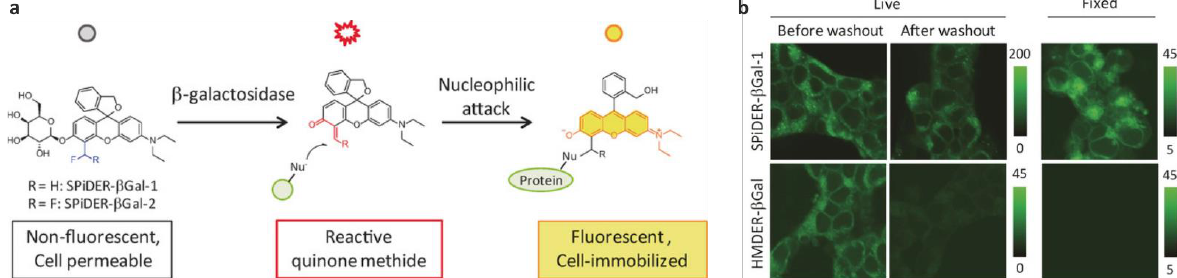
Figure 10. ( a ) Activation eof SPiDER- βGal -1 and -2 . (b) SDS-PAGE visualization of SPiDER- βGal -1 and -2 in comparison with HMDER- βGal in HEK - LacZ (+) cells. ( b ) Fluorescent imaging of HEK- LacZ (+) cells incubated with either SPiDER- βGal -1 or HMDER- βGal (1 µM). Before and after LacZ (+) cells incubated with either SPiDER- β Gal-1 or HMDER- β Gal (1 µ M). Before and after washing copyright 2016 John Wiley and Sons . John Wiley and